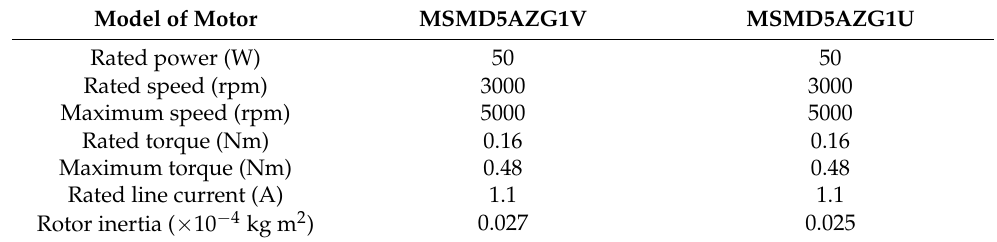
Table 3. Parameter table of AC servo